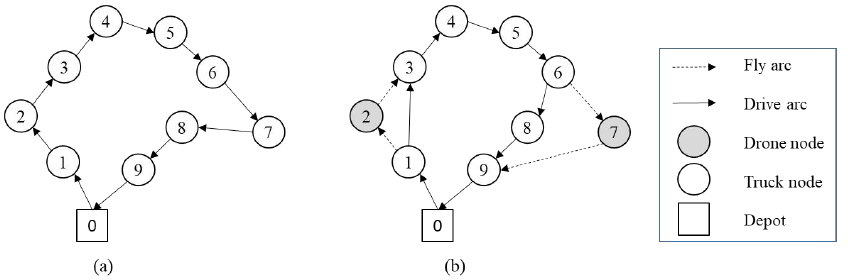
Figure 1. TSP vs. TSP-D for a graph of size n = 9: ( a ) displays an optimal TSP route without the aid of a drone; and ( b ) displays a TSP-D route, where the drone is launched from a truck, delivering parcels to two